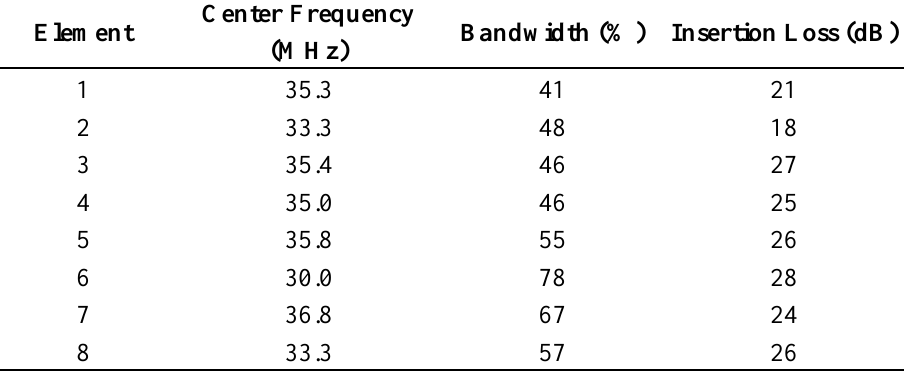
Table 7. Performance of each element for the annular array